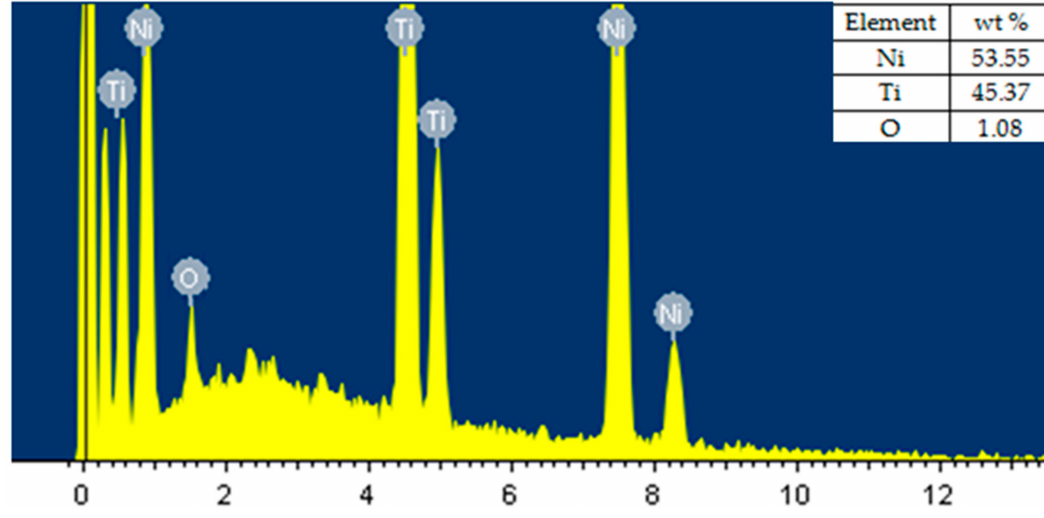
Figure 10. EDX analysis at optimized process